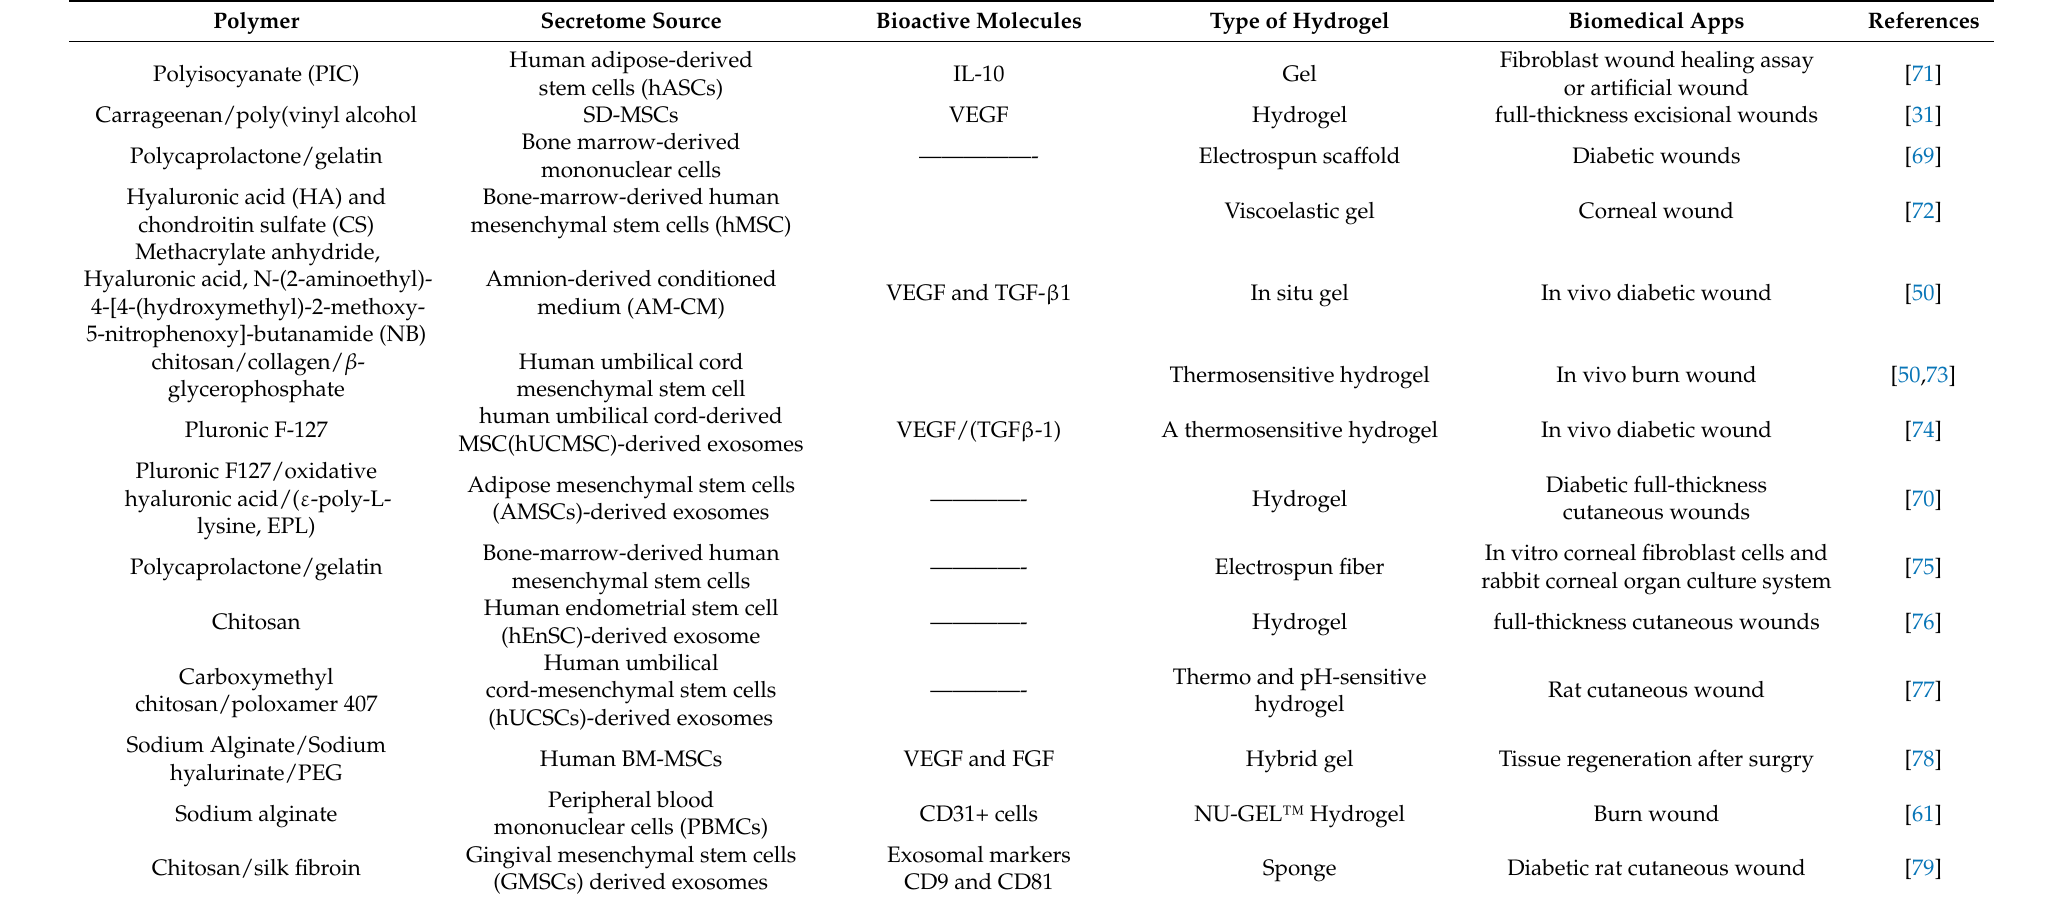
Table 2. Biomaterials and their application in wound